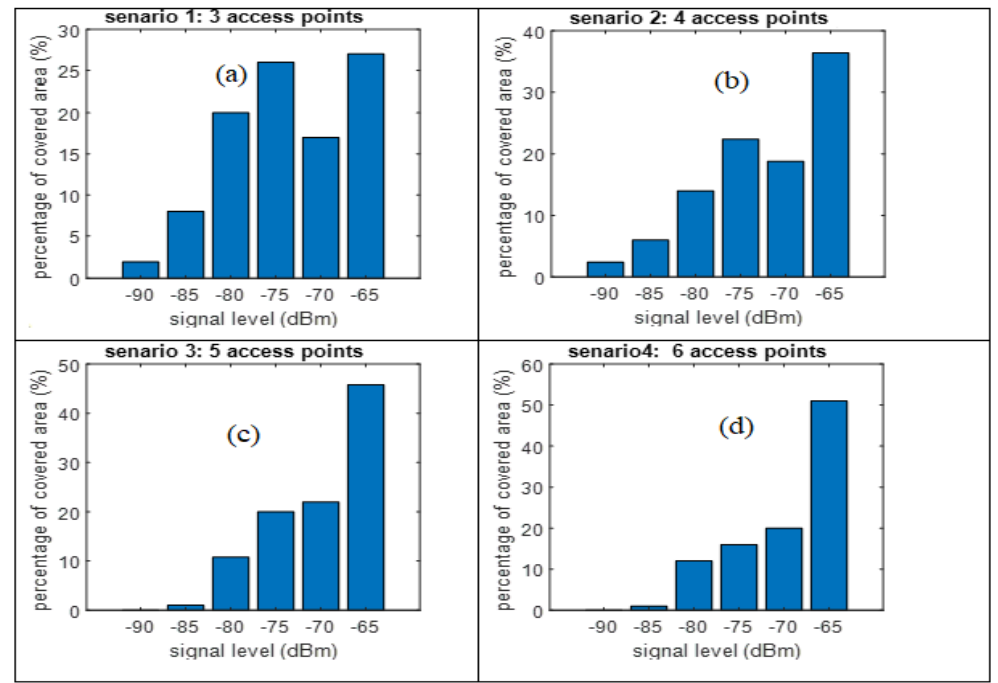
Figure 8. Histogram based on the percentage of areas covered by ( a ) 3, ( b ) 4, ( c ) 5 and 6 ( d ) access points.